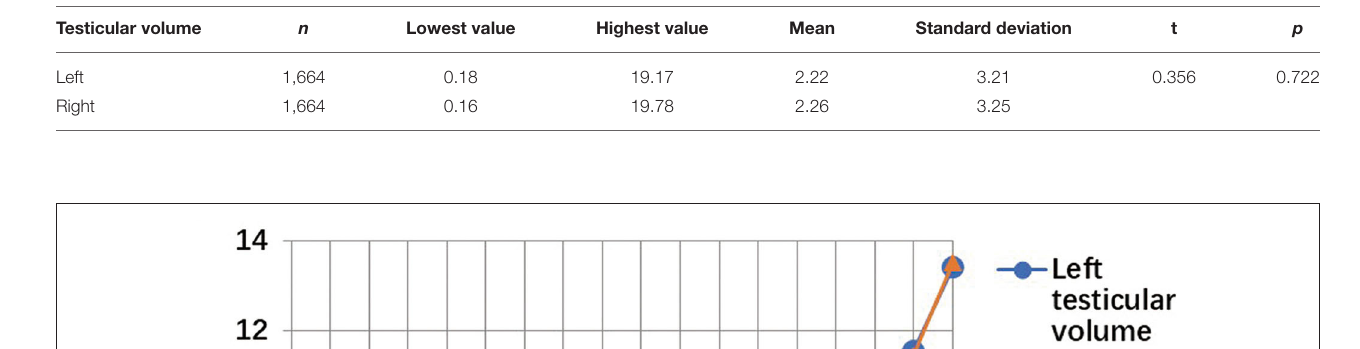
skewness and coefficient of kurtosis of the Z-score regression equation were ( − 0.01226, P = 0.7724) and (0.04513, P = 0.573),